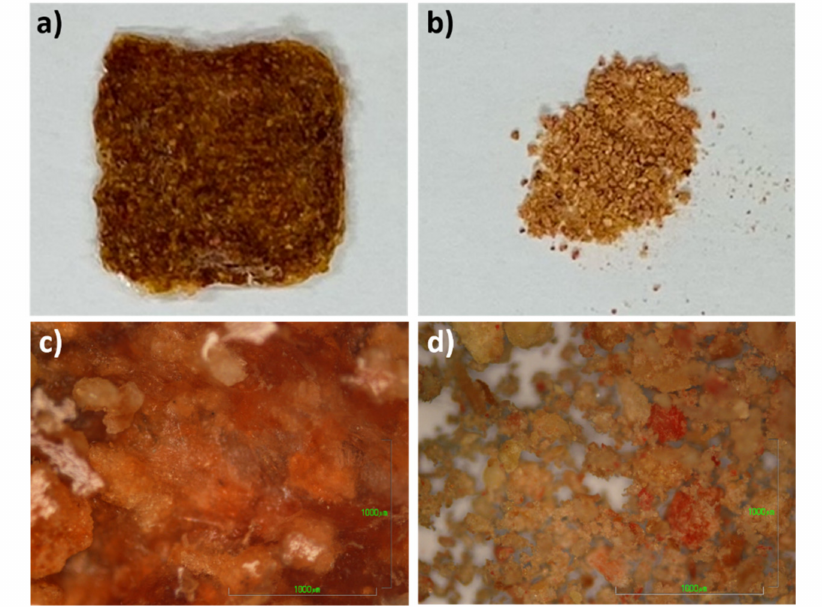
Figure 2. Pictures of active pad ( a ) and pomegranate powder ( b ) and the respective optical im- ages ( c , d